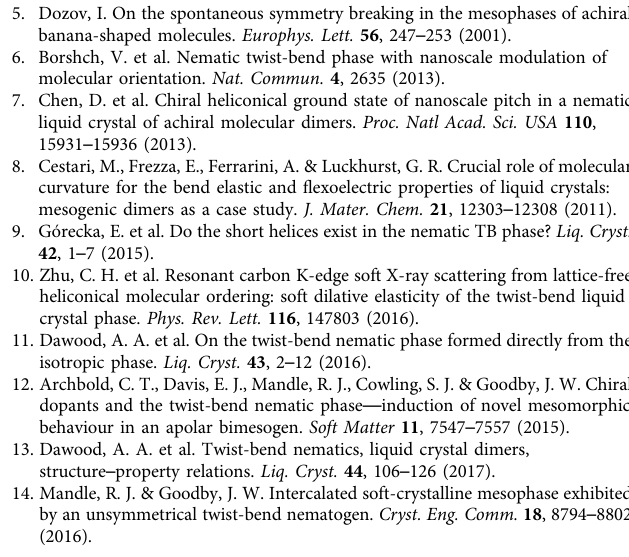
Circular dichroism . The CD spectra were collected with a J-815 spectropolarimeter from Jasco, Japan, using quartz plates as substrates for the samples.